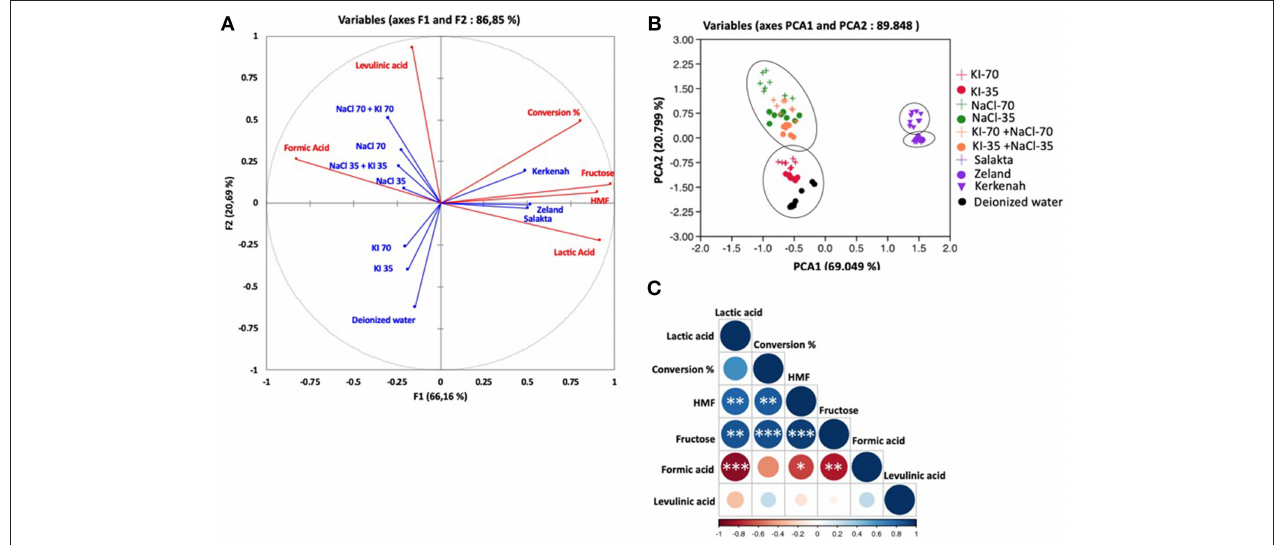
FIGURE 9 | Principal component analysis of molar conversion of D-glucose and its molar conversion efficiency into fructose, formic acid, lactic acid, levulinic acid, and HMF under different salts concentration and seawater treatment. (A) Correlation circle: red lines represent parameters and blue lines refer to the treatments, (B) Observations, and (C) correlation plot. * P < 0.05; ** P < 0.01; *** P < 0.001.